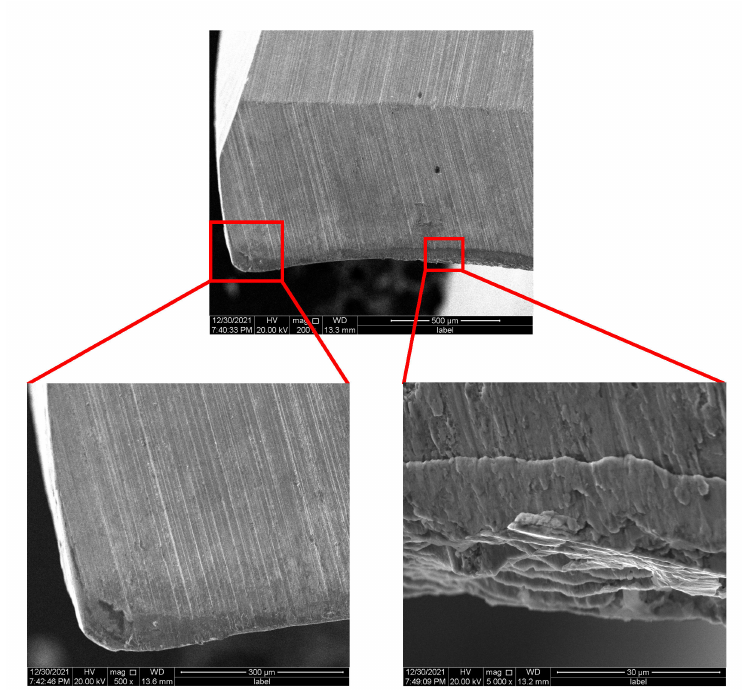
Figure 9. Crack in back of uncoated